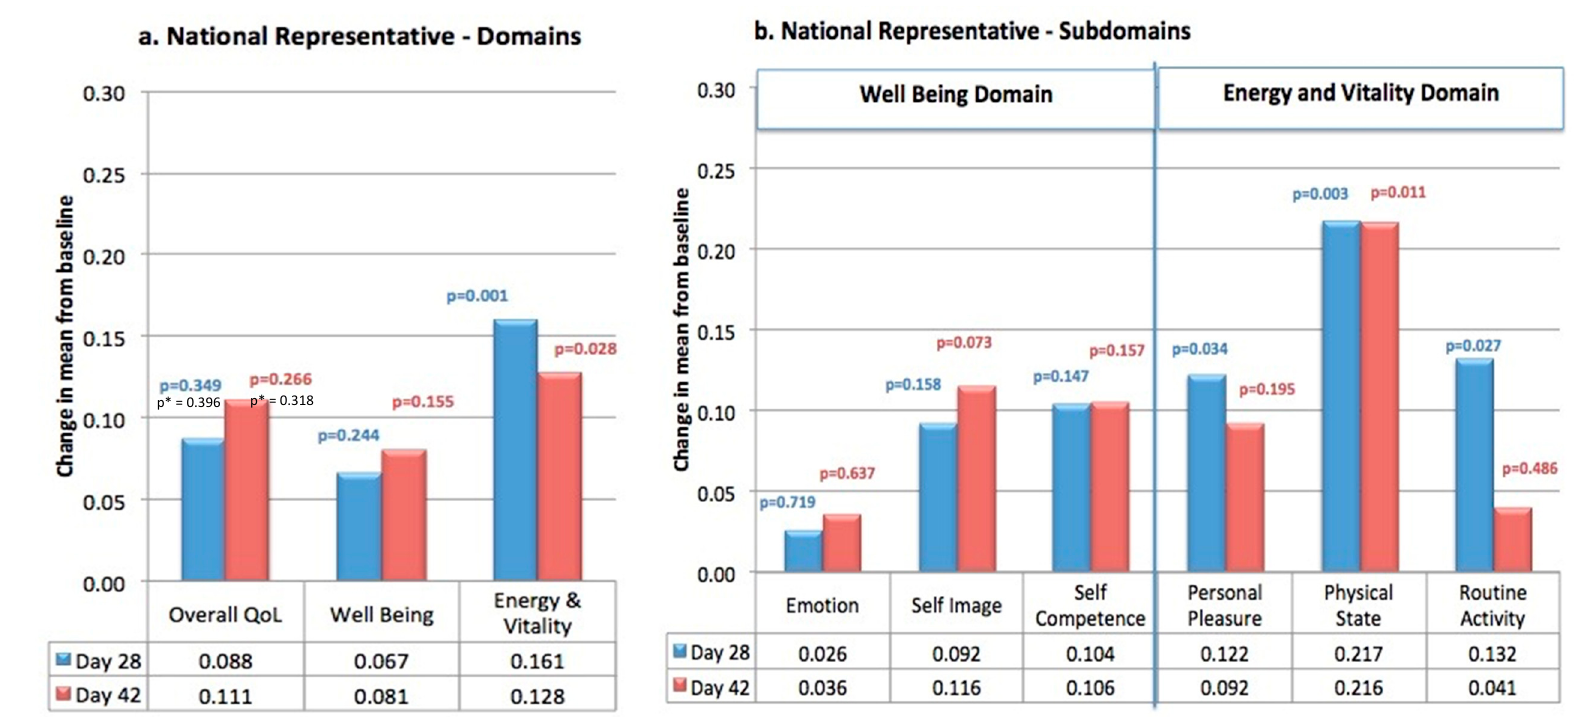
Figure 3. Mean changes in scores for the domains ( a ) and subdomains ( b ) are shown. In this group, 91 participants completed day 28, and 90 completed day 42. The 2-tailed p -values from t -test are reported. For overall quality of life (QoL), the p -values from non-parametric tests are also reported and denoted by p *.